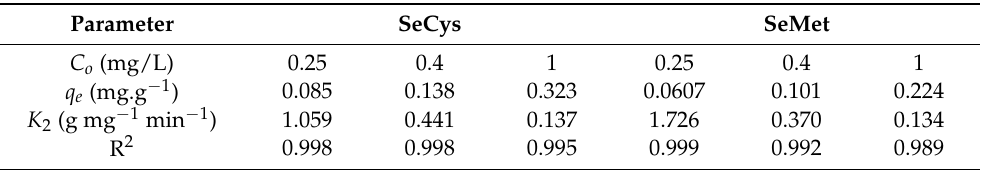
Table 2. Key parameters on effects of initial SeCys and SeMet concentration adsorption onto nZVI/GAC.